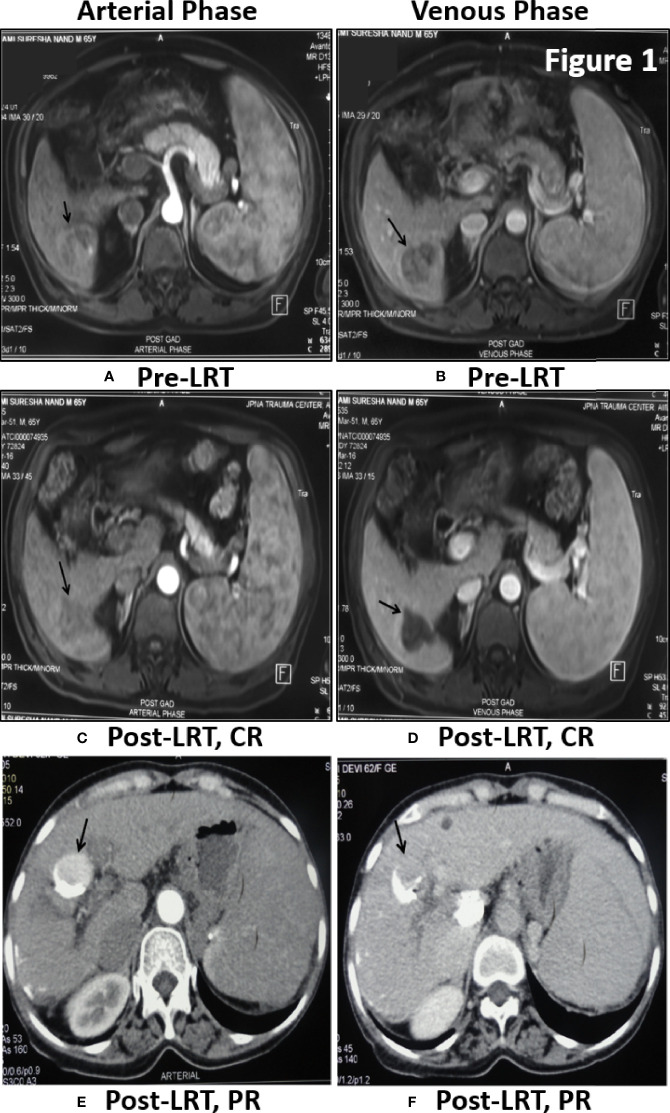
Tumor response assessment by MPCT/MRI of Liver: Post-TACE MRI Scan of 65 yr old male patient of HBV- HCC have shown large solitary HCC in segment 6 showing enhancement in arterial phase (A) with washout in venous phase (B) before treatment. One month Post-LRT in MRI have shown lack of enhancement in treated tumor in arterial phase (C) and venous phase (D) is suggestive of Complete Response (CR). Post-TACE CT scan of 62 yr old female patient of HCV-HCC have shown residual enhancing tumor (black arrow) in arterial phase (E) with washout in venous phase (F). Dense lipidol seen in the lateral aspect of tumor is suggestive of partial response to LRT.